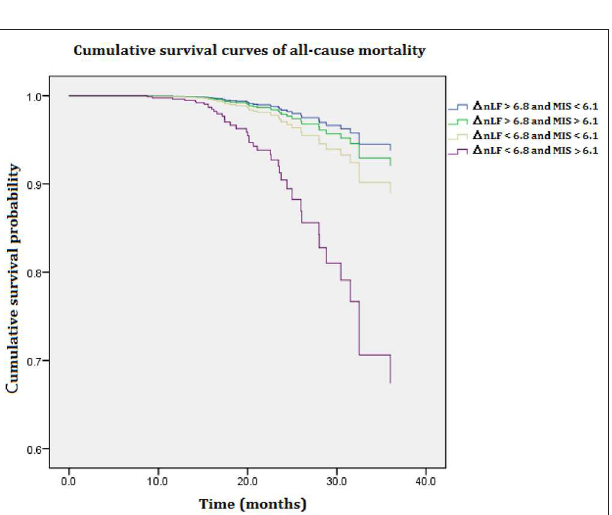
FIGURE 1 | Cumulative survival curves of all-cause mortality with respect to different categories of 1 nLF and MIS score after adjusting for age, diabetes mellitus, CAD, MIS score, and 1 nLF during 5097.6 person-months of follow-up. Combined lower levels of 1 nLF ( < 6.8 nu) and higher levels of MIS score ( > 6.1 nu) was associated with a highest risk of all-cause mortality ( P = 0.037). CAD, coronary artery diseases; MIS, malnutrition-inflammation syndrome; 1 nLF (%), changes in normalized low frequency before and after hemodialysis.